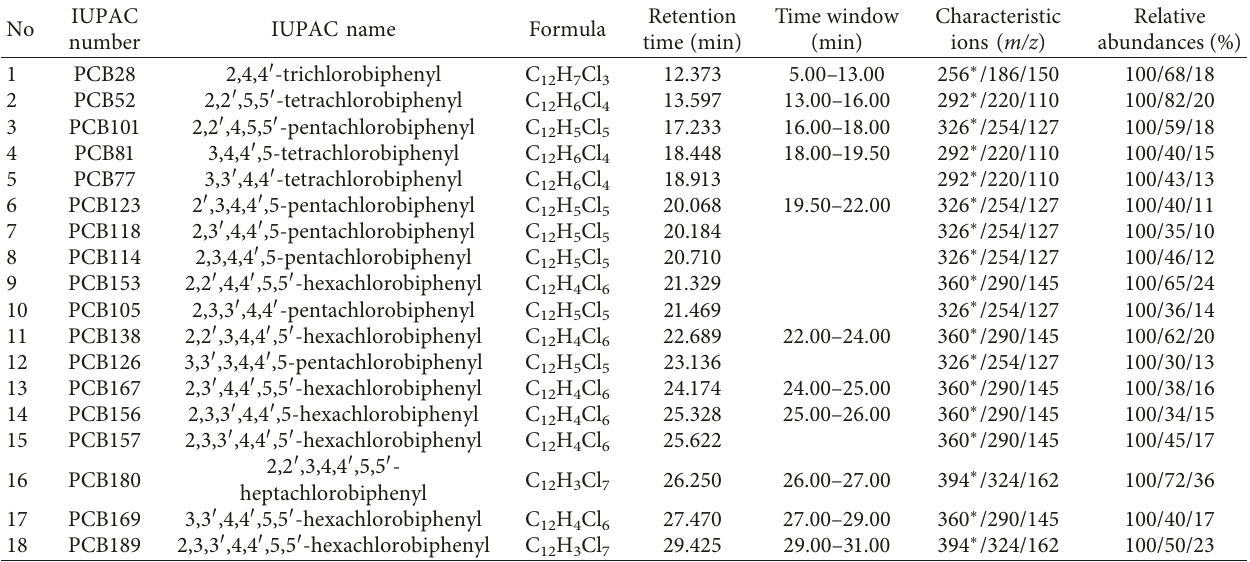
Table 1: Retention times, characteristic ions, and their relative abundance of the 18 PCBs analyzed in the present study. No